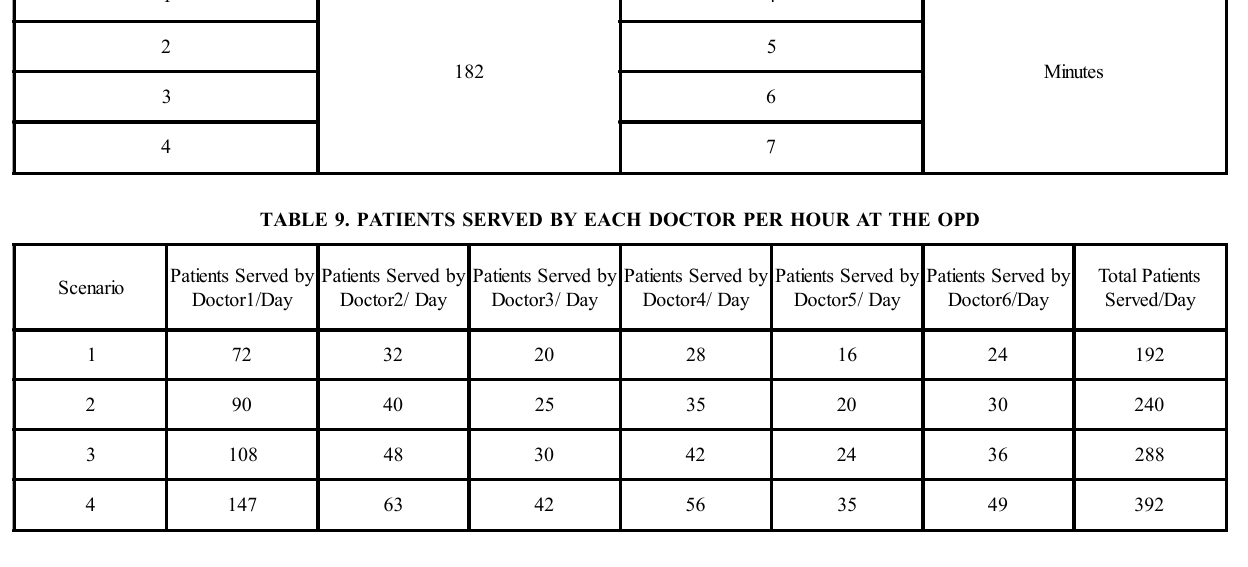
TABLE 10. COST ANALYSIS OF SERVED PATIENTS ACROSS ALL THE